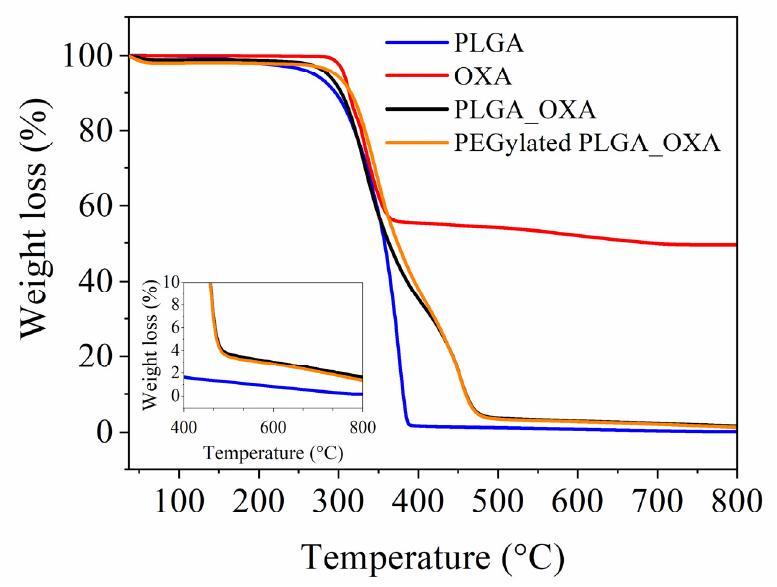
Figure 5. TG curves of pristine PLGA matrix, oxaliplatin (OXA), oxaliplatin-loaded PLGA nanopar- ticles (PLGA_OXA) and oxaliplatin-loaded PEGylated PLGA nanoparticles (PEGylated PLGA_OXA) under nitrogen atmosphere from room temperature (25 °C) to 800 °C at a heating rate of 10 °C·min − 1